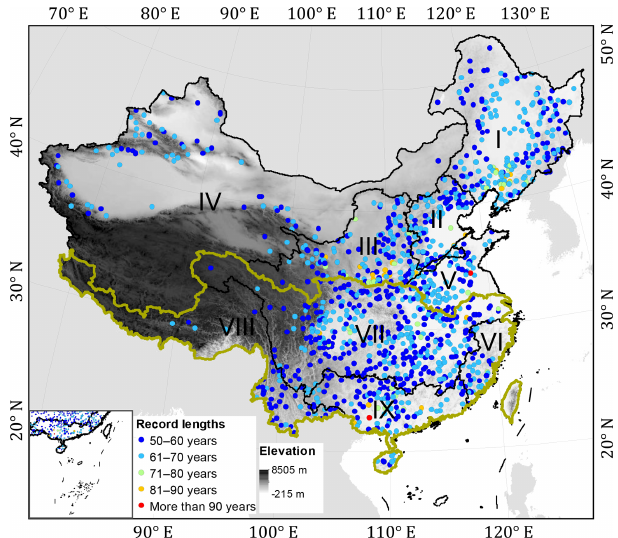
Figure 1. Overview of the stream gauging stations with record lengths of more than 50 years over China (1120 gauges in total). Scatter shading represents the record length (in years) for each station. The grey shading represents topography, while the black lines represent the first-level hydrologic units. The Roman numerals highlight the nine major hydrologic units in China: I northeastern river basins, II Hai He basin, III Yellow River basin, IV northwest- ern river basins, V Huai He basin, VI southeastern river basins, VII Yangtze River basin, VIII southwestern river basins, and IX Pearl River basin. Olive line shows the boundary of river basins in south- ern China (VI–IX) with the rest of the river basins in northern China